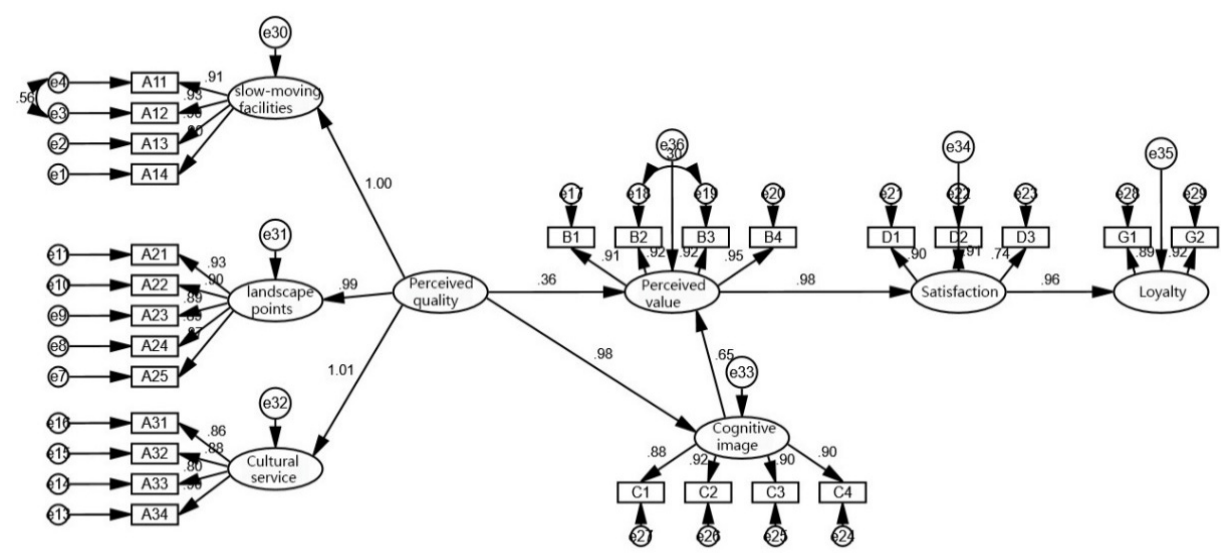
Figure 3. Path hypothesis